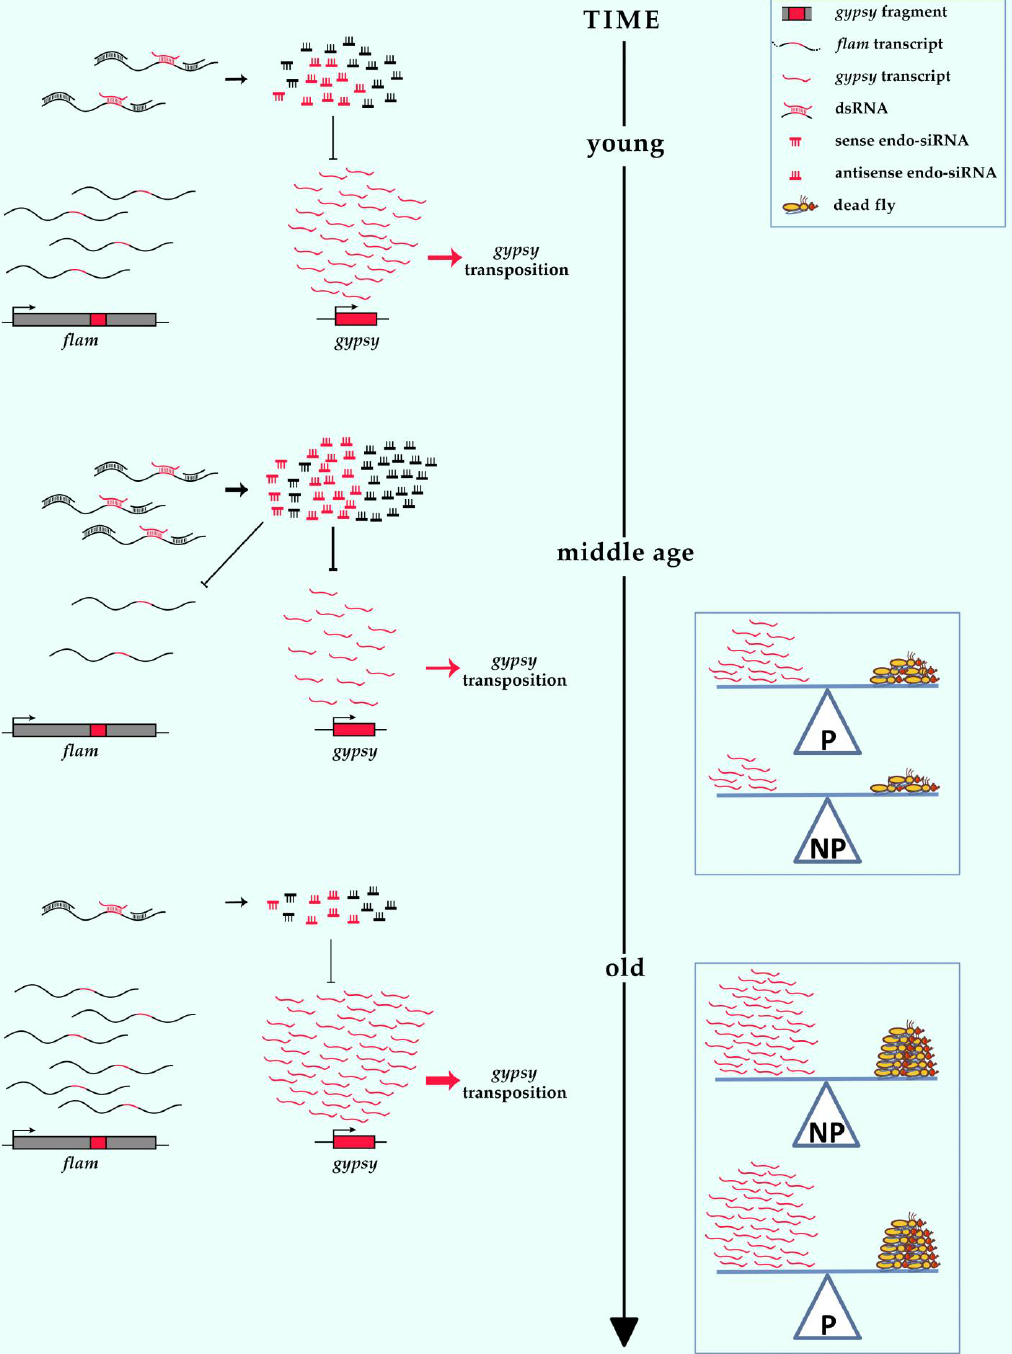
Figure 3. A speculative model for gypsy regulation during the aging process. flamenco is highly enriched in antisense TE sequences, comprising gypsy fragments. The flamenco primary transcript can form double strand RNAs (dsRNAs) with gypsy sense transcripts that serve as substrates for the production of endo-siRNAs specific for the silencing of gypsy . In young flies, gypsy expression